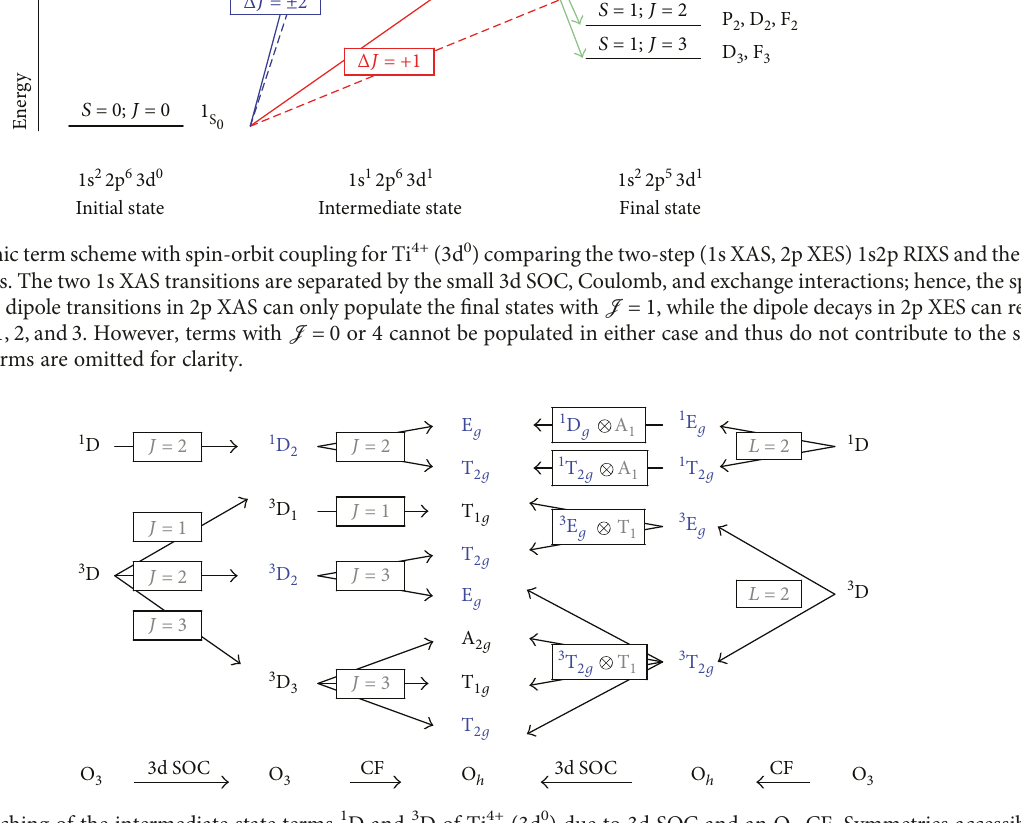
CF. Symmetries accessible in the h